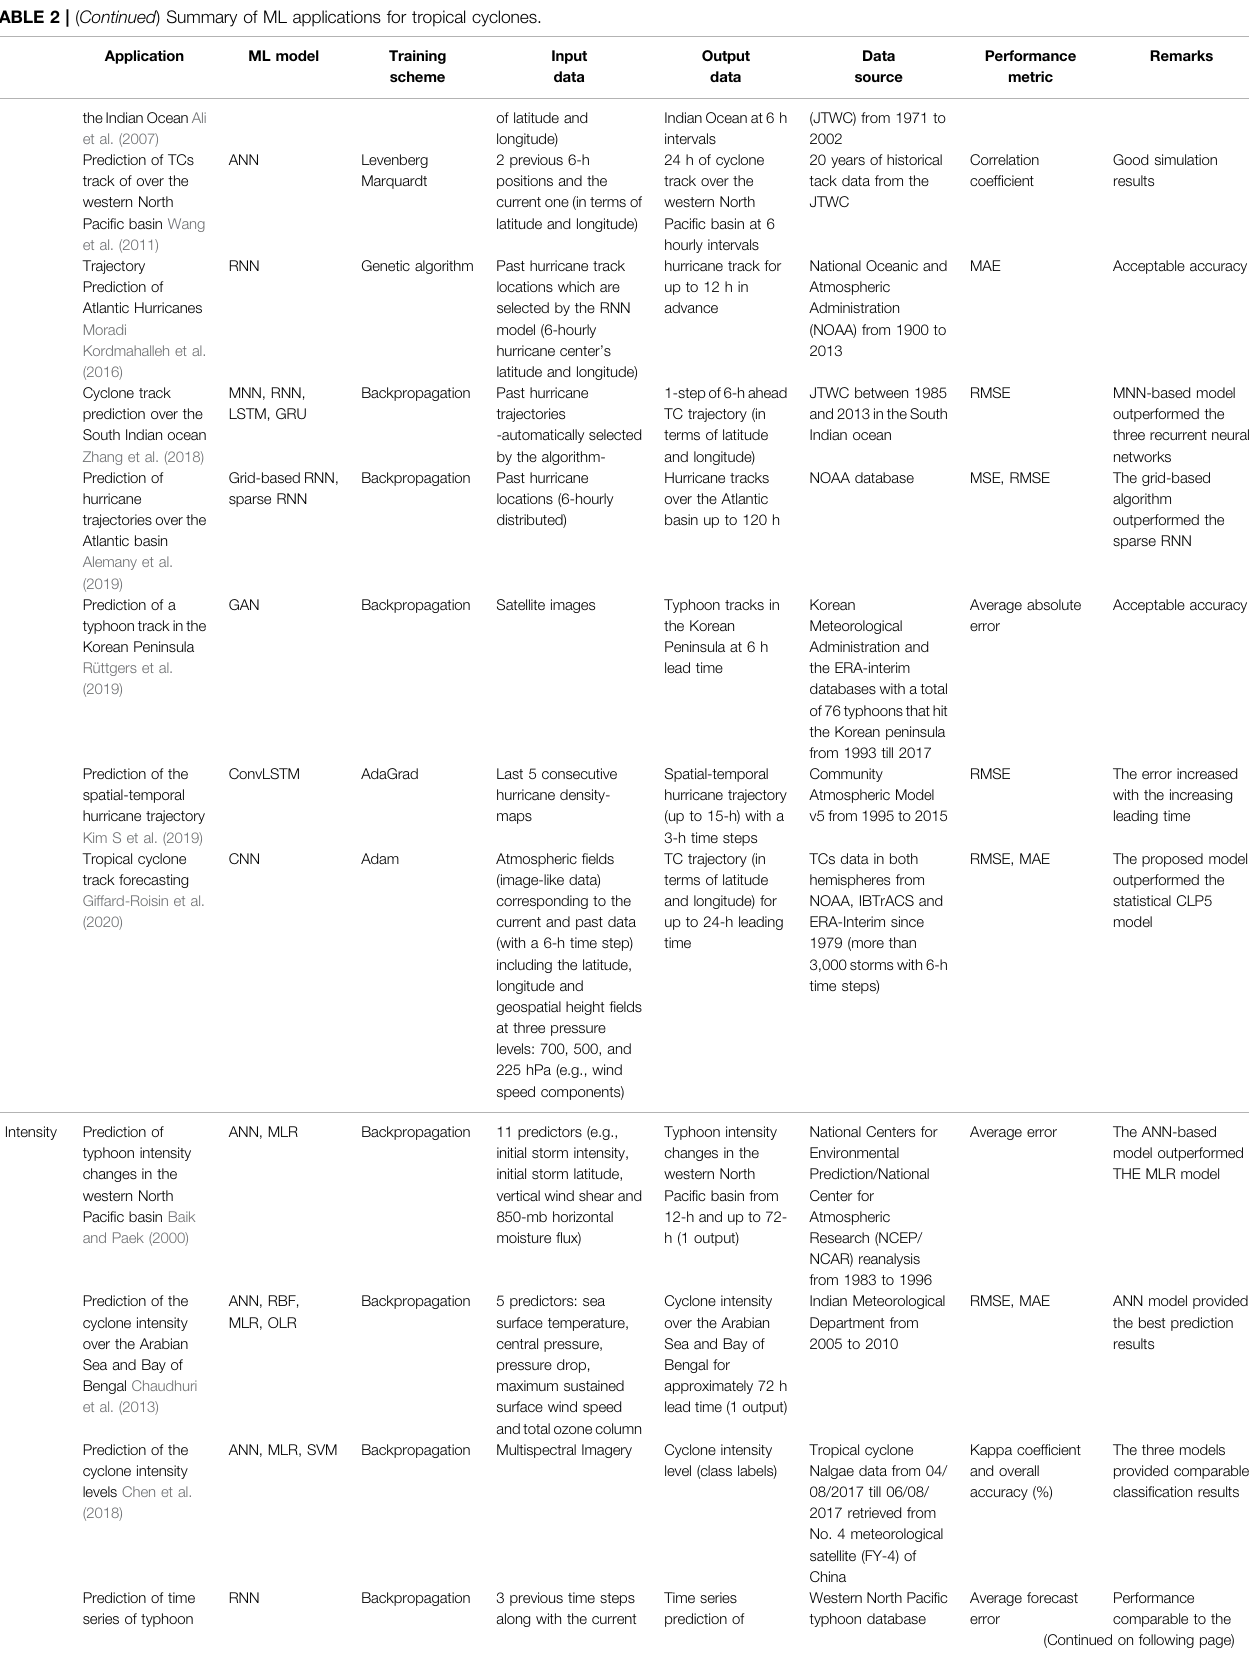
TABLE 2 | ( Continued ) Summary of ML applications for tropical